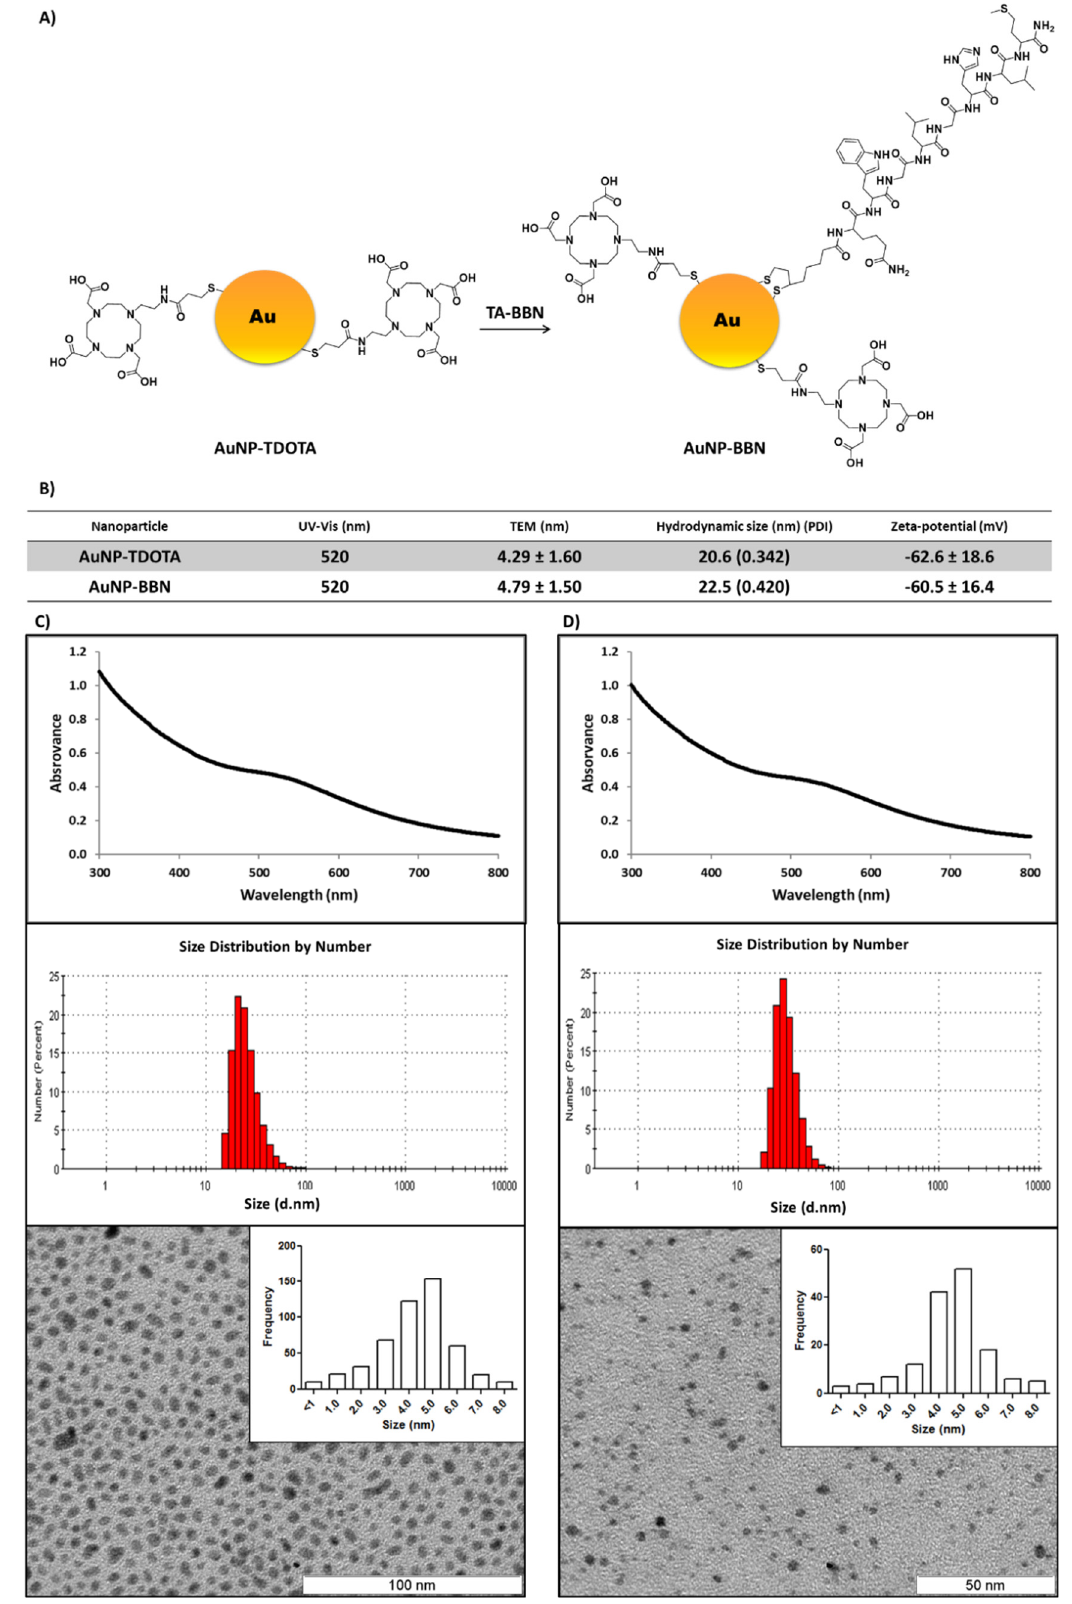
Figure 2. Schematic synthesis of AuNP-BBN from AuNP-TDOTA ( A ). Physico-chemical characterization of the AuNPs used in the present work ( B ). UV-Vis spectra, dynamic light scattering analyses and transmission electron microscopy imaging (with respective size histogram), of AuNP-TDOTA ( C ) and AuNP-BBN ( D ).